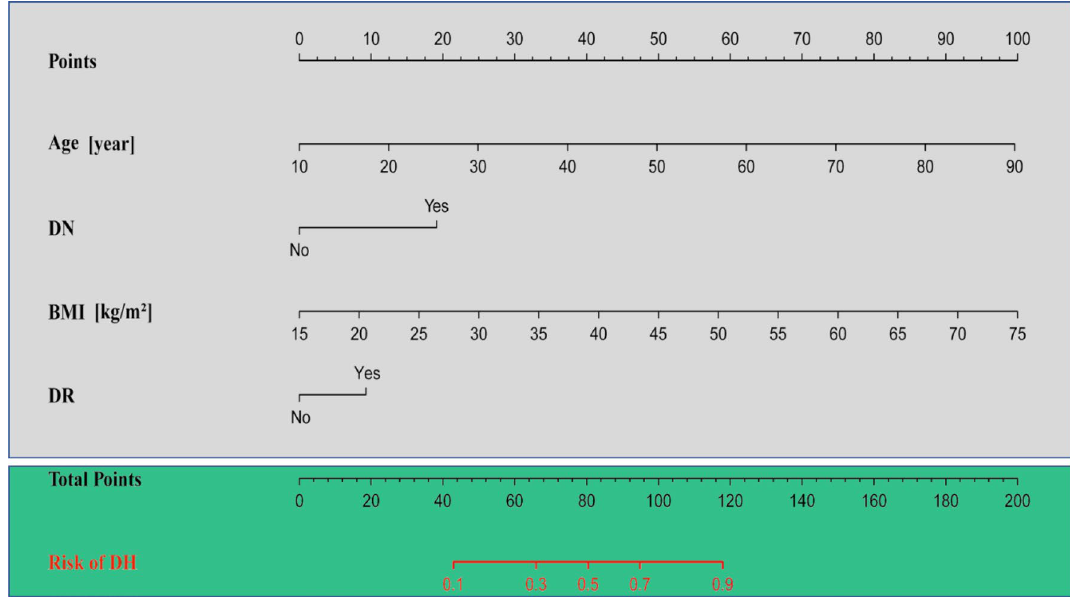
Figure 3. Nomogram for predicting DH. Age, DN, BMI, and DR are the variables of the prediction model.